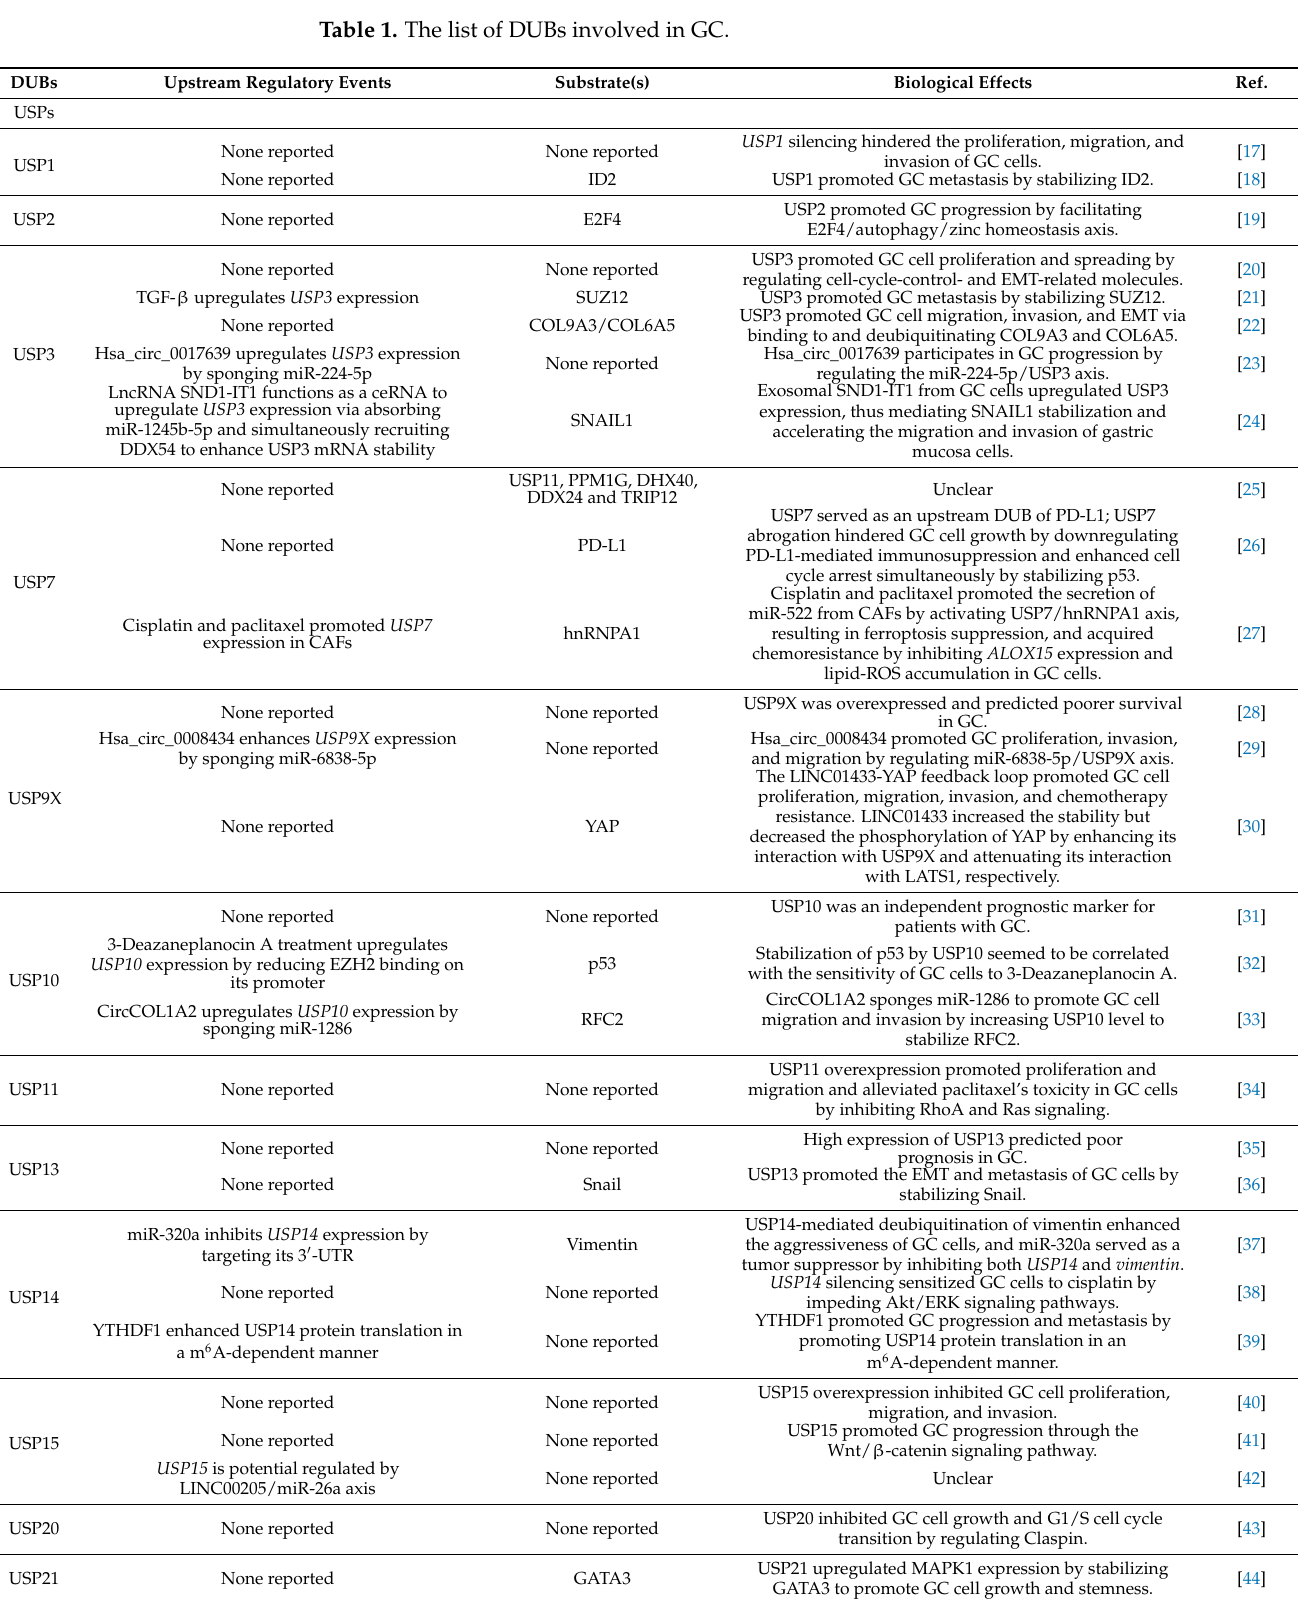
Table 1. The list of DUBs involved in